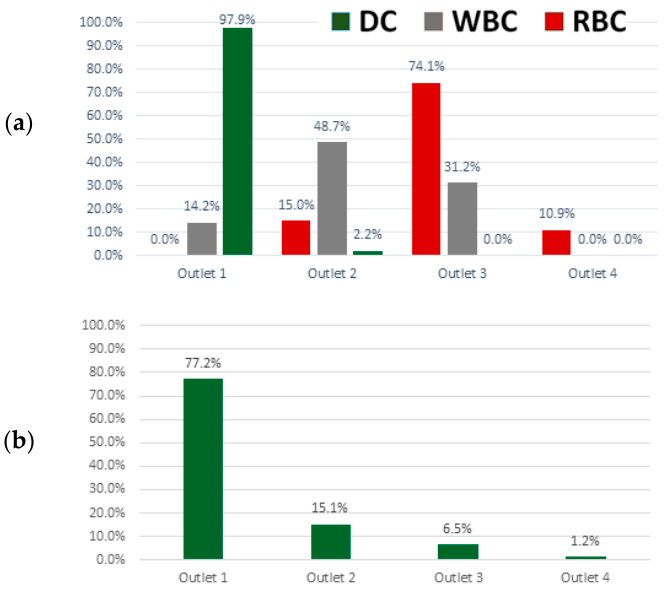
Figure 4. Evaluation of blood-cell-separation efficiency at a flow rate of 1.9 mL/min: ( a ) the majority of dendritic cells are collected in Outlet 1, white blood cells in Outlet 2 and red blood cells in Outlet 3 when the spiral microfluidic device is tested with fluid containing a single cell type only at 100X dilution. ( b ) The majority of dendritic cells are still collected in Outlet 1, although with lower efficiency, when tested with fluid containing all three types of blood cells.